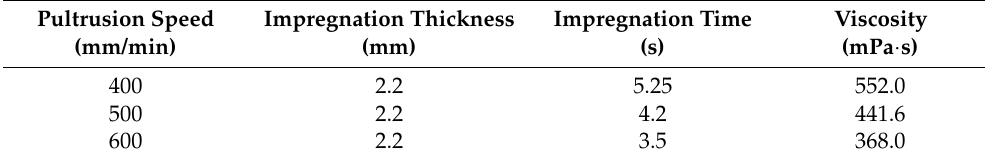
Table 2. Viscosity of the resin required for full impregnation with different pultrusion speeds. Pultrusion Speed